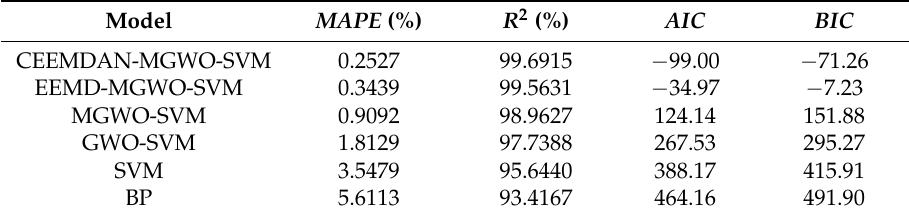
Table 9. Comparison of the forecasting accuracy for different